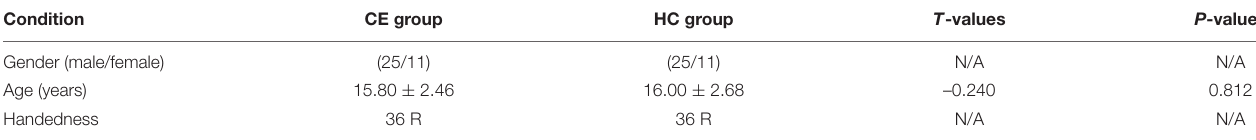
TABLE 1 | Demographics and visual measurements between two